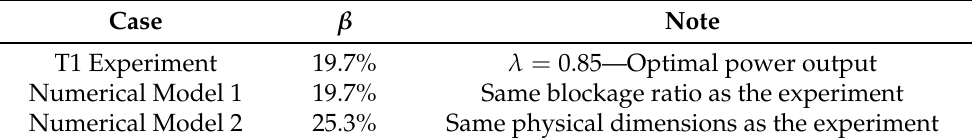
Table 3. The cases of interest for experimental and numerical comparison of the near-wake.